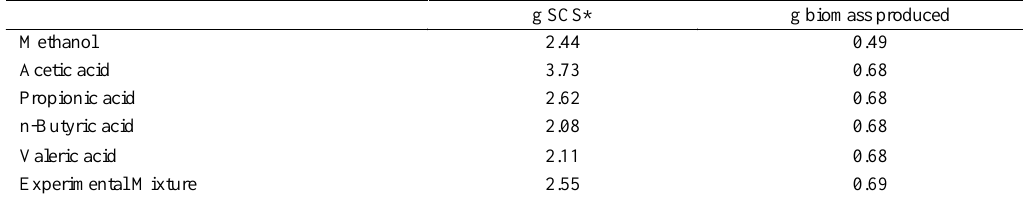
Table 7: Comparison of the methanol and VFA mixture based on stoichiometry